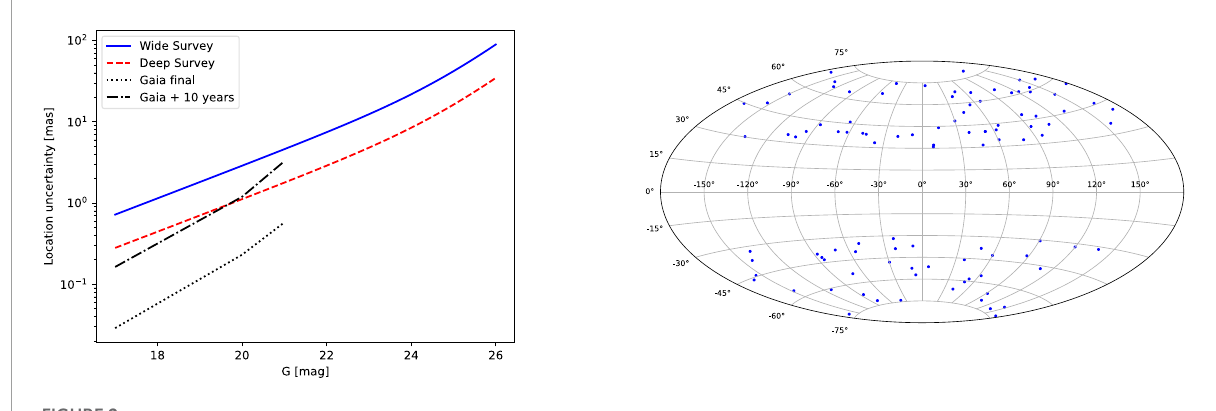
FIGURE 2 Left: approximate plot of position uncertainty vs. magnitude for unresolved sources with near solar color in CSST-OS observations, in the Wide Survey (solid blue line), Deep Survey (dashed red line), and Gaia position uncertainties, final (dotted black line) and extrapolated to CSST epoch (dashed-dotted black line). Right: field positions (in Galactic coordinates) selected for simulation of Gaia catalogue update by CSST-OS